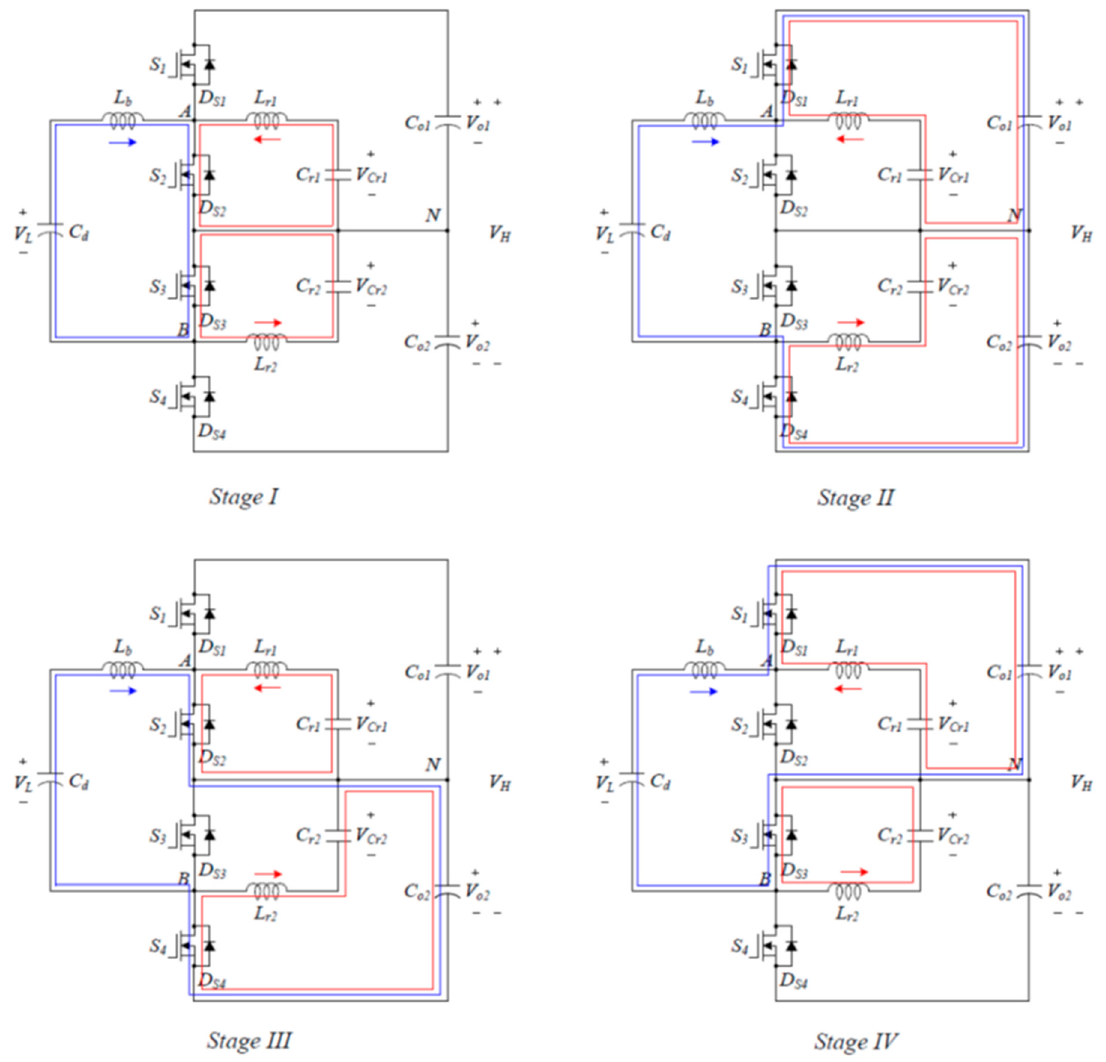
Figure 3. The circuit diagram of the proposed converter according to the switches’ states in the step-up step-up mode.